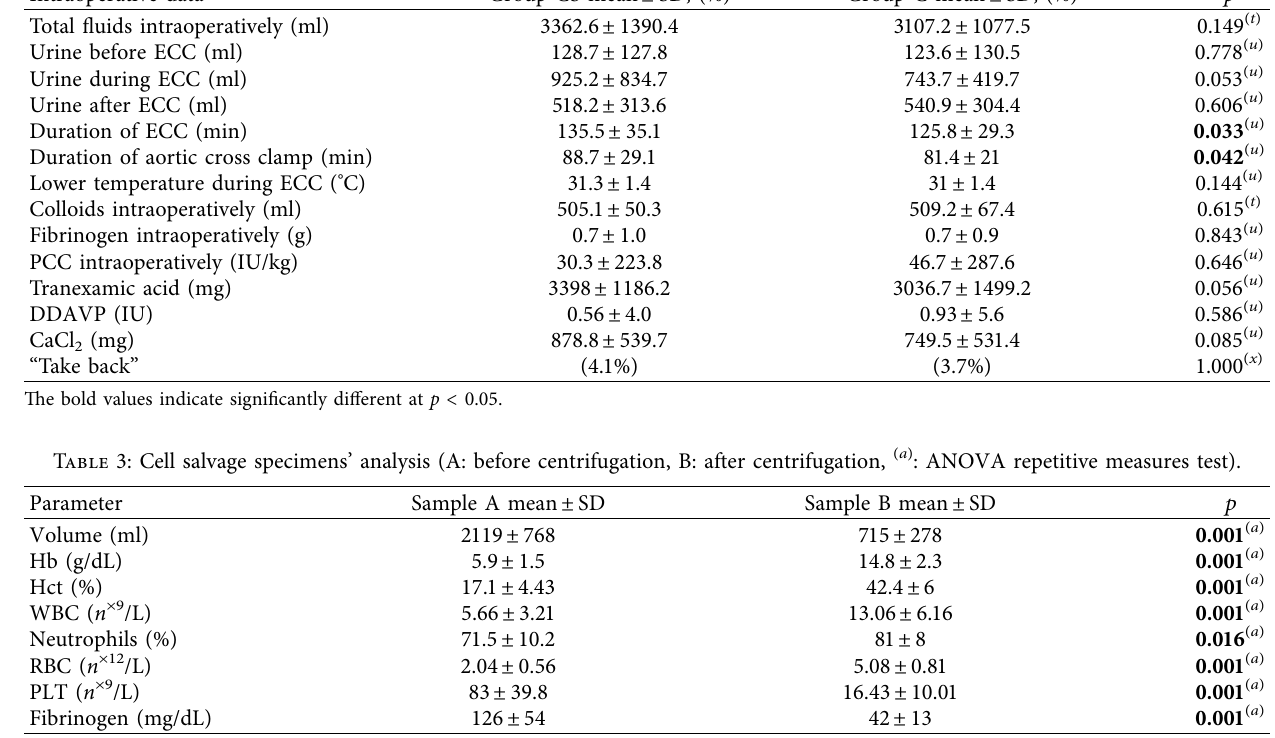
Table 2: Perioperative fluid balance, extracorporeal circulation characteristics, and administration of coagulation products ( ( t ) : student’s t - test, ( u ) : Mann-Whitney U -test, ( x ) : x 2 test).